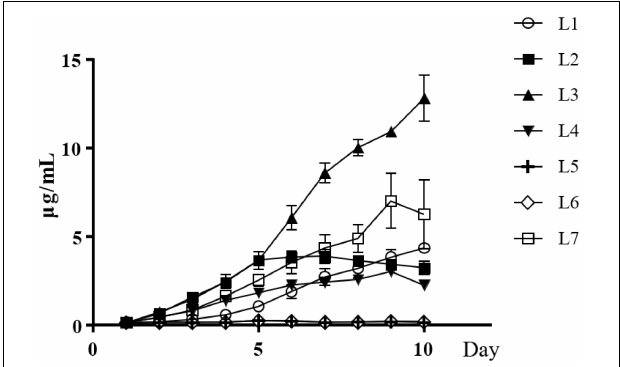
FIGURE 2 | IAA production by seven Streptomyces isolates, Streptomyces wuyuanensis L1, Streptomyces cinereoruber L2, Streptomyces palmae L3, Streptomyces lincolnensis L4, and Streptomyces zaomyceticus